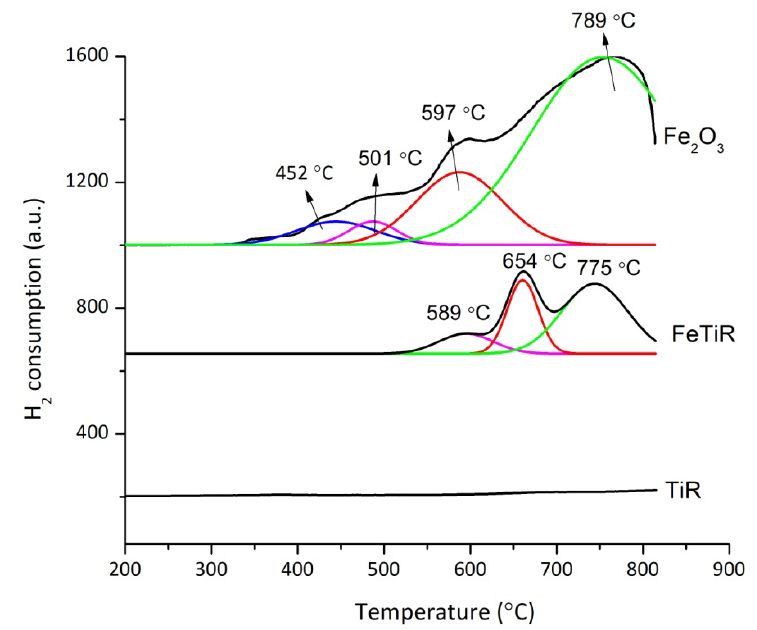
Figure 10. Temperature-programmed reduction behaviour of the investigated samples.